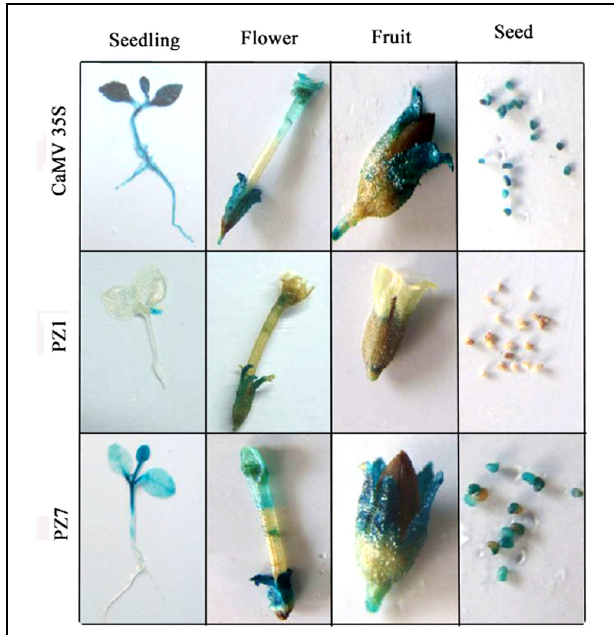
FIGURE 4 | Histochemical GUS staining in tissues of PZ1, PZ7, and CaMV35S transgenic tobacco. Two-weeks-old tobacco seedlings, flowers, fruits, and seeds were incubated in staining solution at 37 ◦ C for 24 h. Then the samples were observed and photographed after